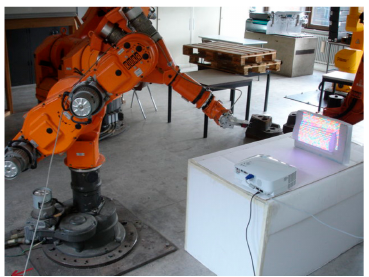
Figure 16. Robot positioning using structured light [96].